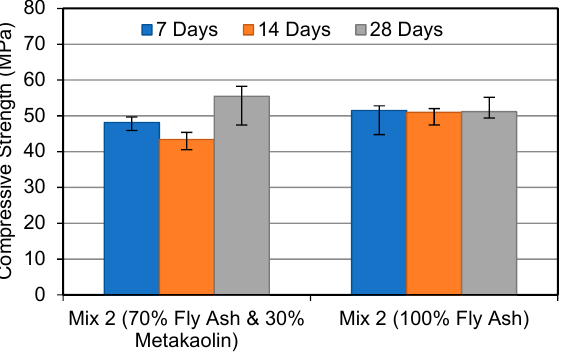
Figure 1. Compressive strength development at alkaline solution molar ratio 1.0.